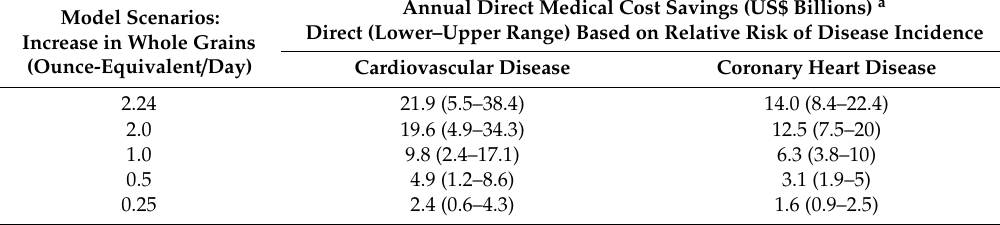
Table 2. Annual direct medical cost savings associated with increased consumption of whole grains among adults in the US.